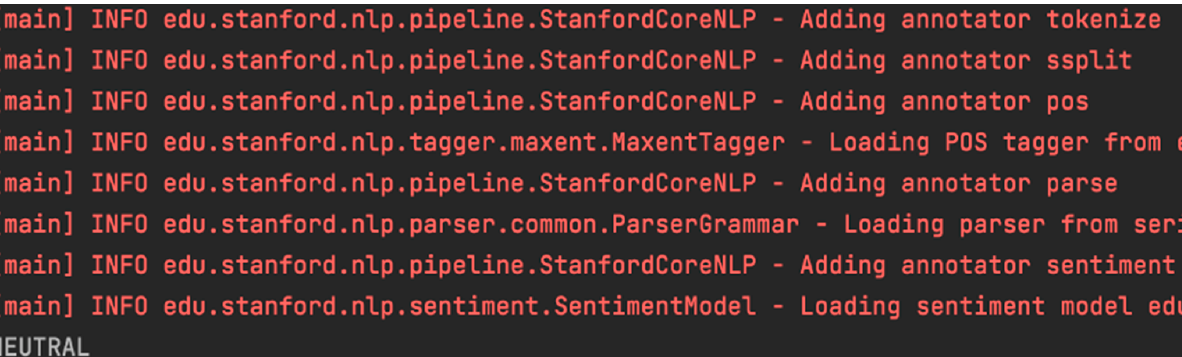
Figure 6. Sentiment analysis result.